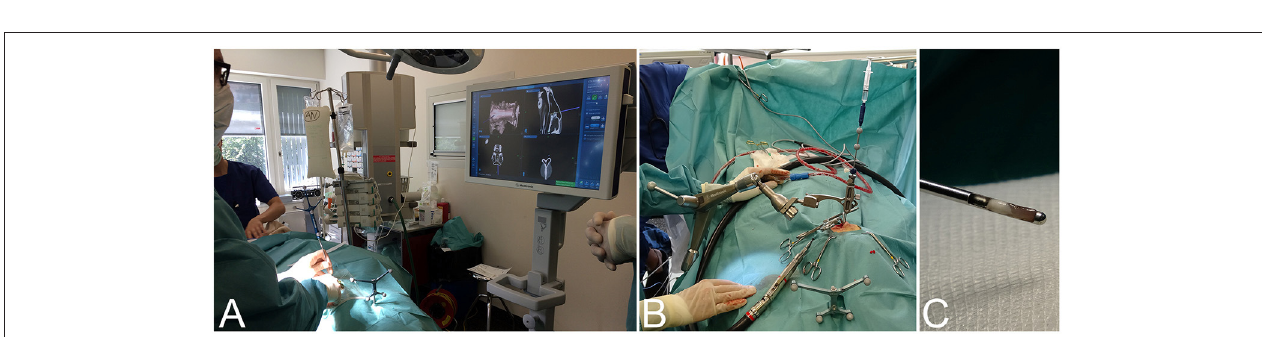
FIGURE 2 | Transverse T2-weighted (A) and T1-weighted contrast enhanced (B) image and of an 11-year-old female spayed Poodle with biopsy proven vasculitis and meningoencephalitis of unknown origin. Corresponding intraoperative cone beam computed tomography (CBCT) image (C) for image fusion. (D) Example of image fusion of the CBCT images with magnetic resonance images of a 9-year-old female spayed German Shepherd Dog with a biopsy proven WHO grade II cerebellar diffuse astrocytoma.